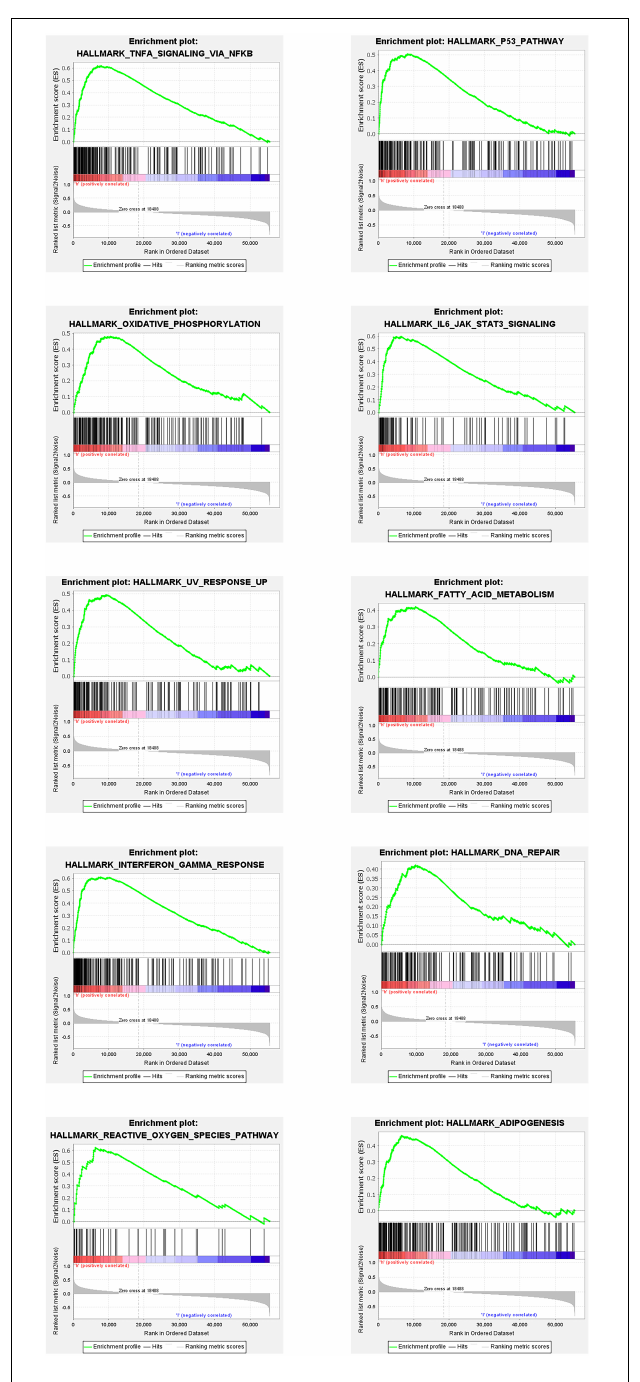
FIGURE 3 | Top 10 enrichment plots from gene set enrichment analysis